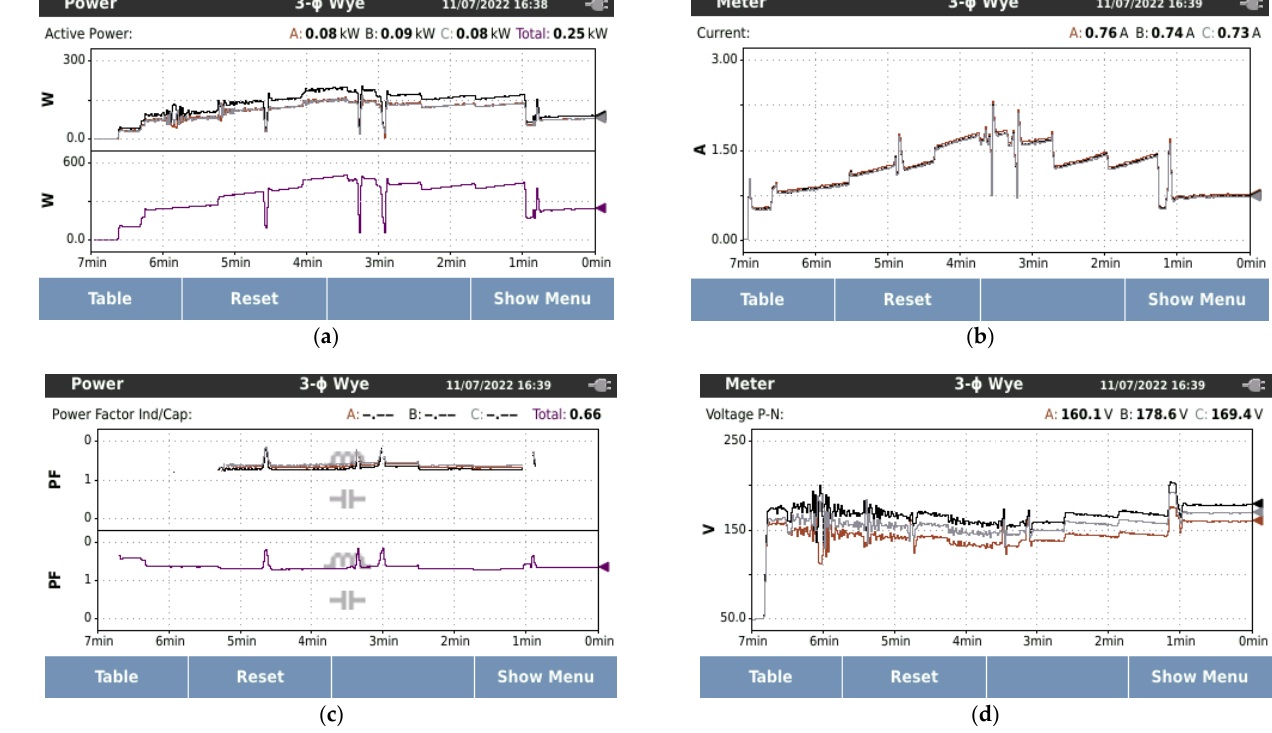
Figure 17. Real-time active power, power factor, voltage, and current using data logger.